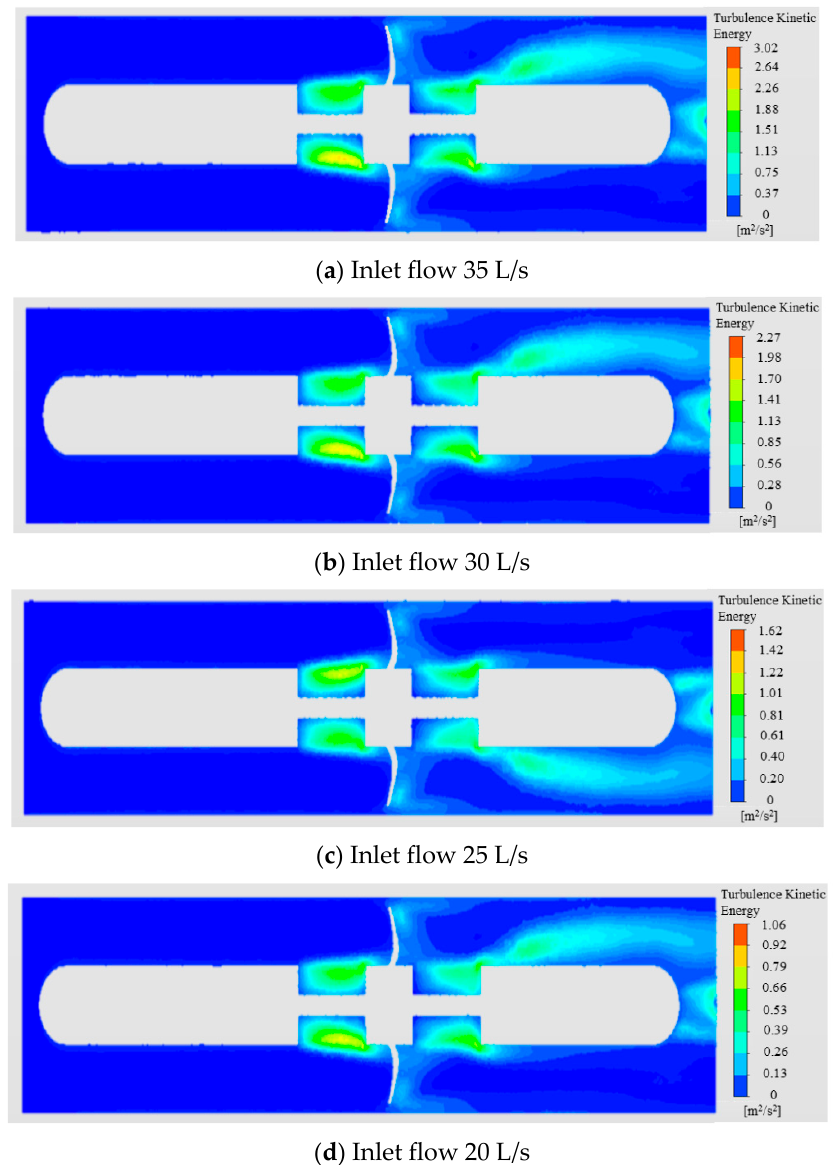
Figure 7. Cloud map of internal turbulent kinetic energy distribution under four flow rates.